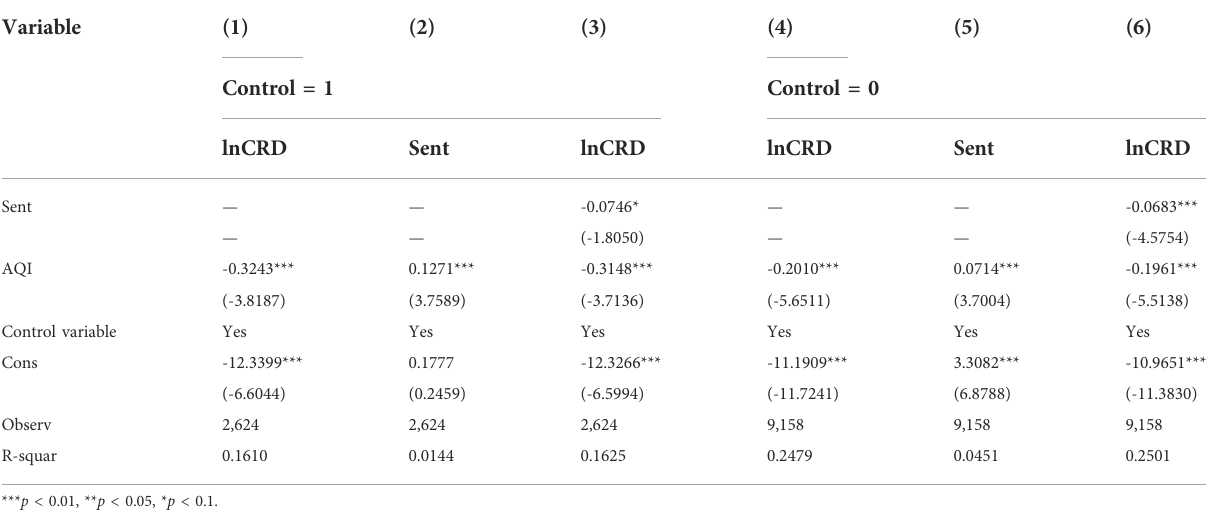
TABLE 12 Heterogeneity analysis of key regulatory enterprises based on investor sentiment. Variable